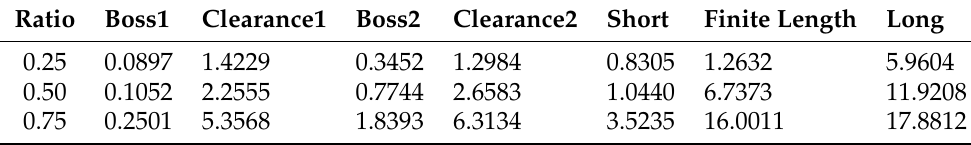
Table 2. Damping (Ns/m) of the inner oil film of the ERSFD in the suspension. Ratio